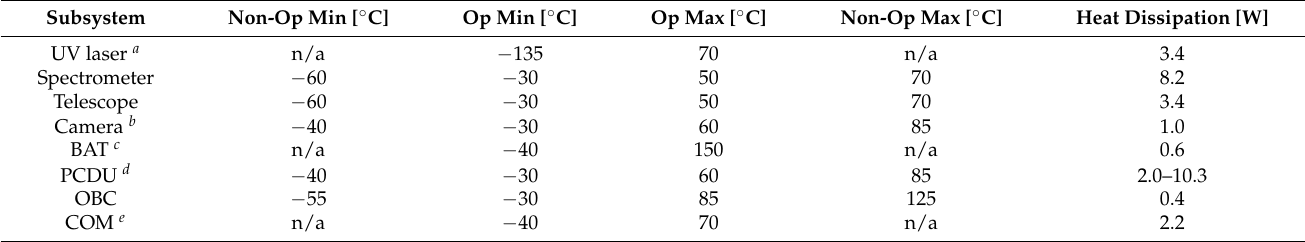
Table 8. Temperature requirements (non-operational and operational) and estimated heat dissipation of all subsystems.